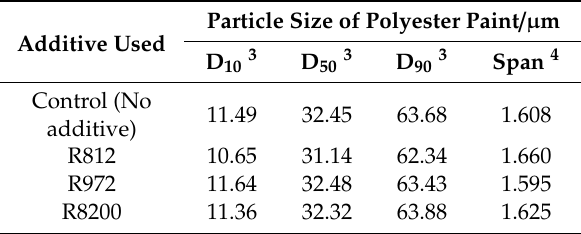
Table 3. Particle size and size distribution of